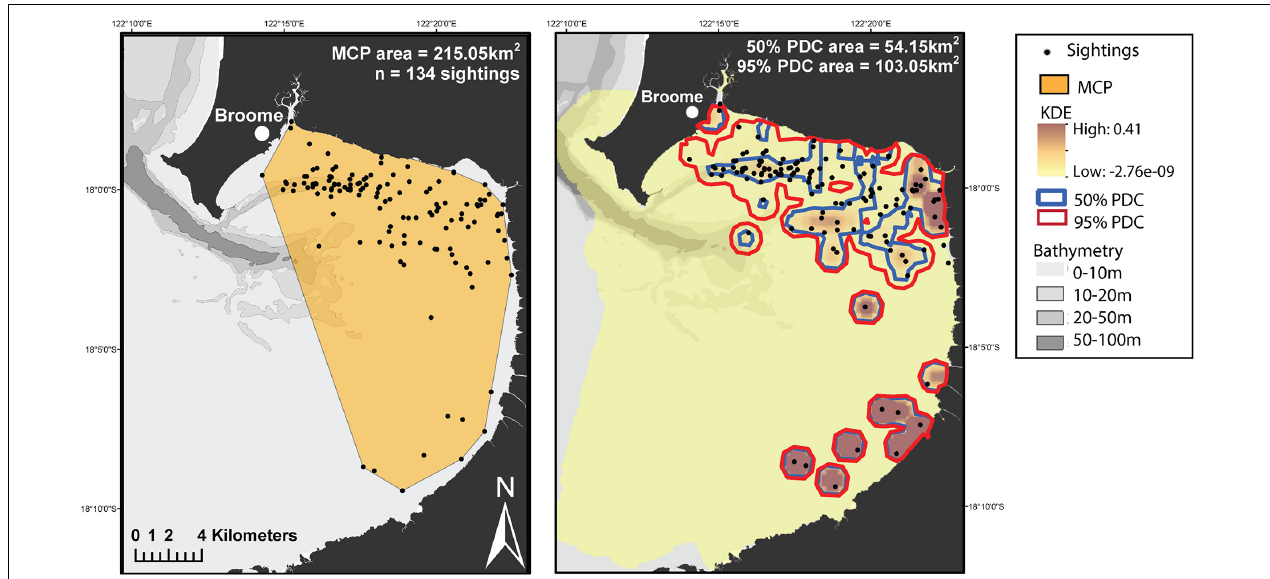
FIGURE 3 | Ranging pattern estimations for the Yawuru Nagulagun snubfin dolphin population using the minimum convex polygon (MCP) method and a kernel density estimate (KDE) of effort-weighted group dolphin sightings showing 50% and 95% percentage density contours (PDC) (i.e., core and representative area, respectively).